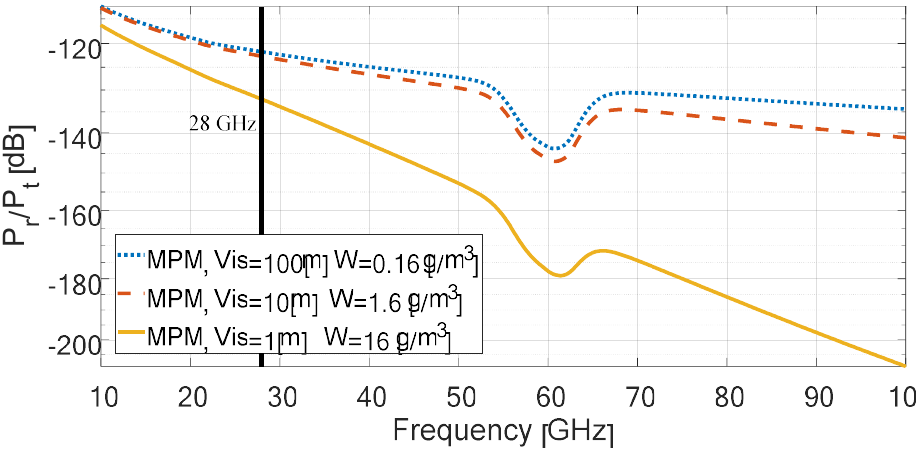
Figure 2. Graphs of the power ratio Pr/Pt as a function of frequency expected at distance of 1 km, assuming omni-directional antennas for different visibility levels.